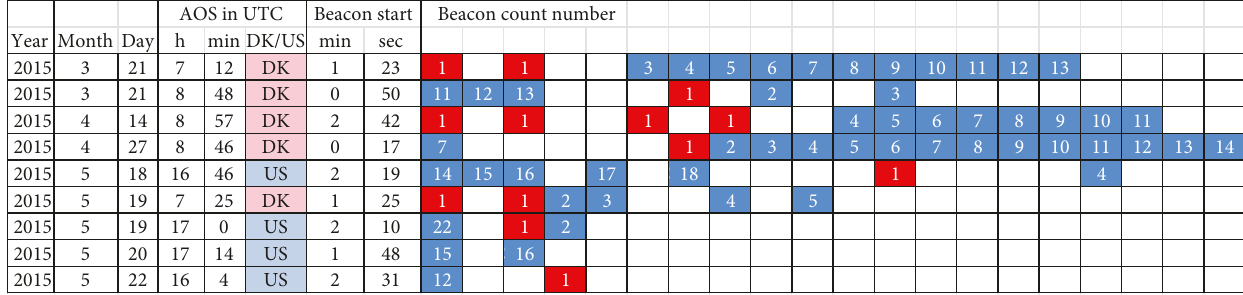
South towards North. Red squares indicate beacon number = 1 . Blue squares indicate subsequent counts, i.e., beacon count number larger than 1.